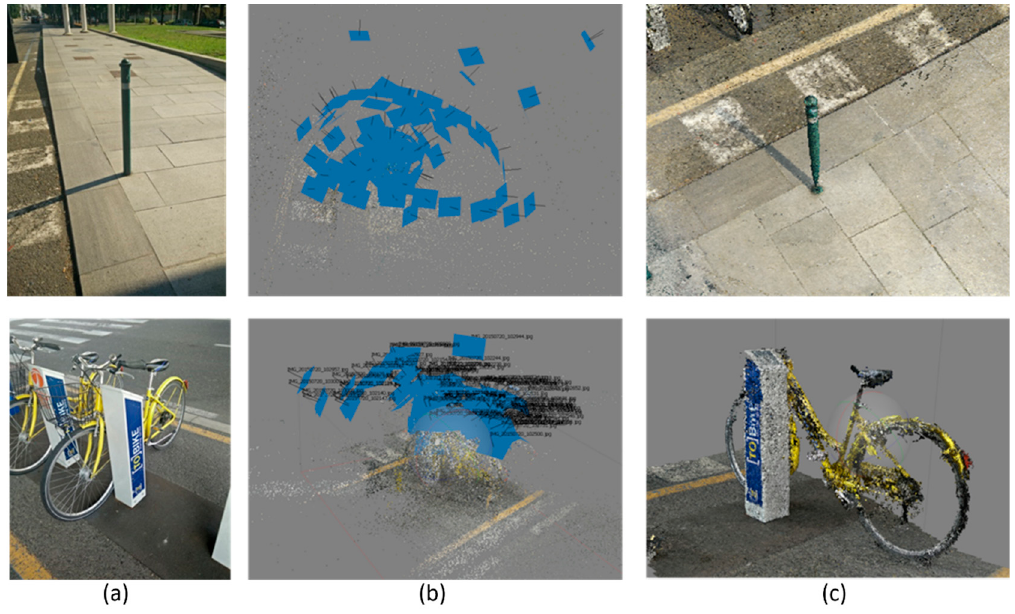
Figure 4. 3D object reconstruction by structure from motion (SfM), applied along the road section of the case study. ( a ) Street furniture was first photographed from different angles with a smartphone; ( b ) the software relocates the images to the correct spatial location and extracts a 3D point cloud; ( c ) the cloud is densified and points are used to build the 3D surface of objects.